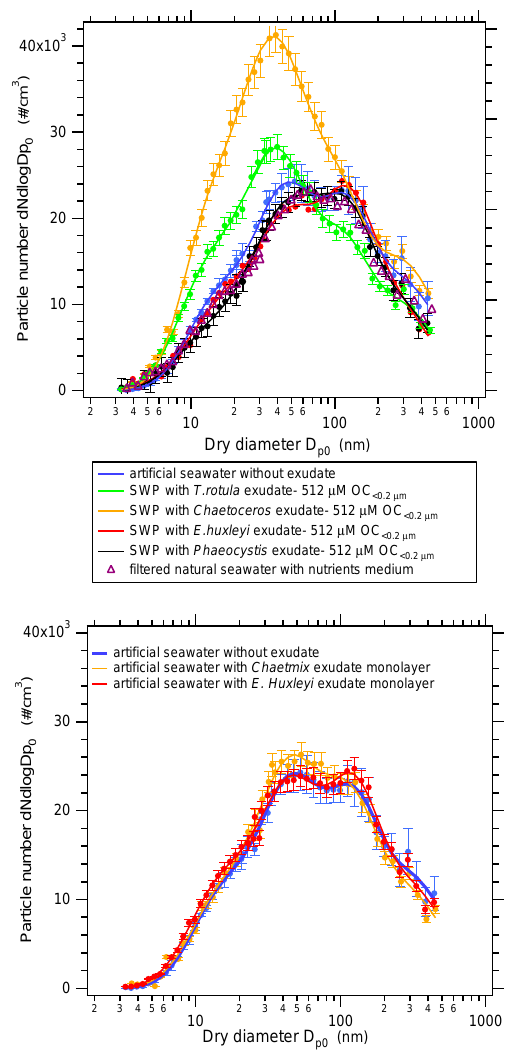
Fig. 10. Comparison of the particle size distribution for artificial seawater without added surfactants and seawater proxies (SWP) en- riched with single algal exudates at 512µM OC < 0 . 2 µ m concen- tration (top) and size distributions obtained with the monolayer method (bottom). The size distribution obtained from filtered nat- ural seawater with added nutrients (=filtered natural seawater with f/2 medium) is included for comparison. Error bars indicate the variability of the measurements obtained from 6 scans during 1 h period as ± 1 σ standard